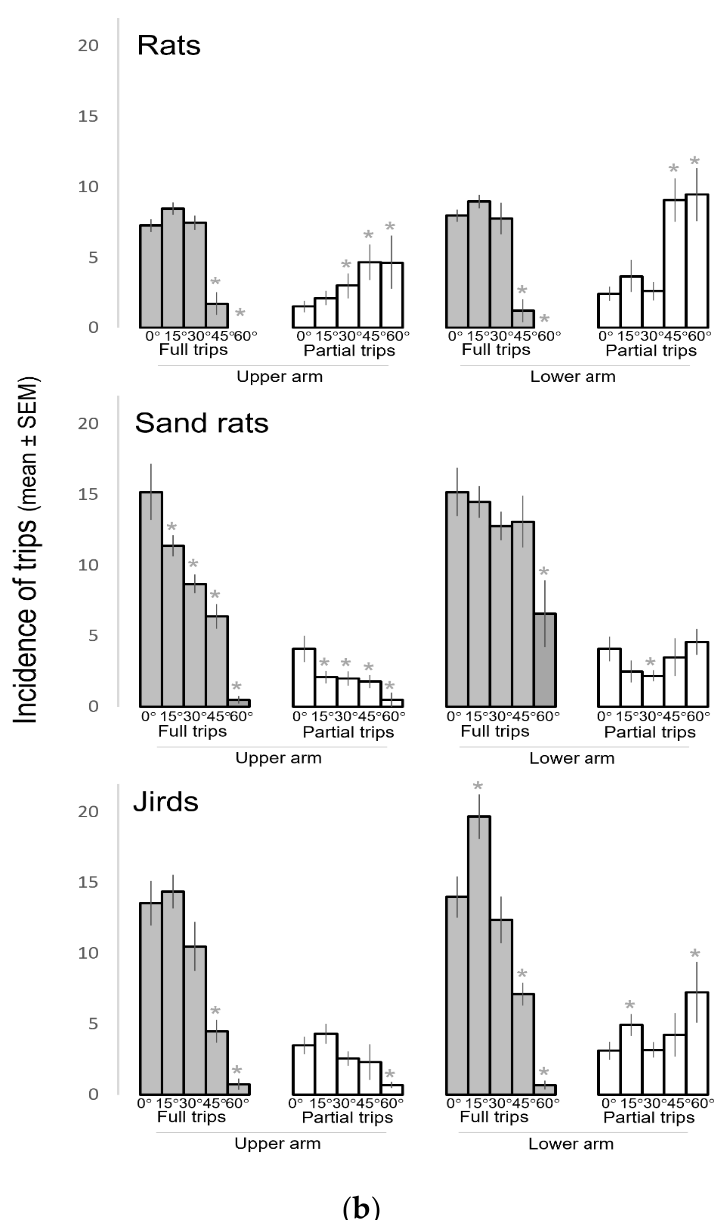
Figure 3. ( a ) Kernel Density Estimation of the maximal distances traveled in each entry to the upper and the lower arms, by each of the three species. The abscissa is a smoothing of the distances traveled in each entry to either the upper or lower arms, representing roughly the length of the arms (60 cm). Note that the X,Y,T coordinates that were extracted from Ethovision refer to the center of the body image of the rodents and therefore 0 on the abscissa represents about half the body inside one of the arms, and 50 represents the arrival to the far end of the arm. The ordinated represents the smoothen distribution of the incidence of the length of entering the arms. As shown, distribution in all three species was bimodal, with either very short entry to the arm (partial trips), or entering the arms all the way to their end (full trips). ( b ) Mean (± SEM) of full trips and partial trips for each species and each inclination of the upper and lower arms. * indicates a significant difference in Dun- net ’s test, compared with the 0° inclination. As shown, in all species and in both the upper and lower arms there were more full than partial trips, but the incidence of the former decreases with the in- crease in inclination. The sand rats were exceptional, showing a significant decrease only at the 60° inclination. In all species, partial trips increased with the increase in inclination, especially apparent along the lower arm and in rats.